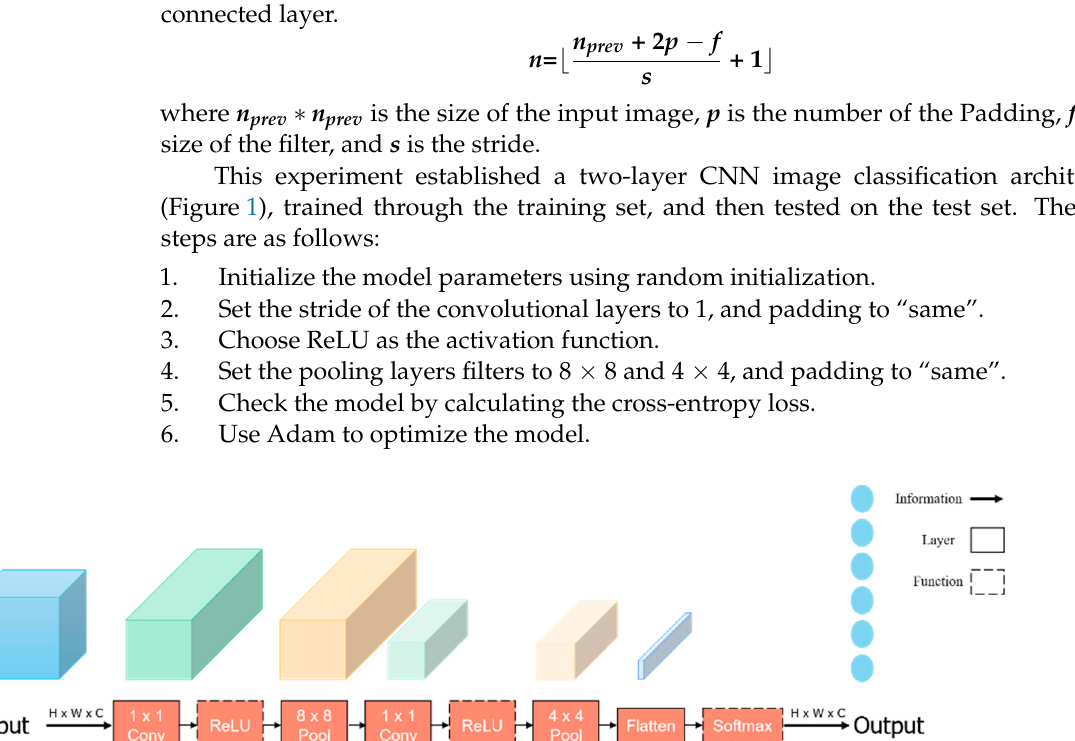
Figure 2. Schematic diagram of the result of the CNN classification model. 3.2. ResNet Model When the network continues to deepen, the deep ordinary network is less capable of selecting the parameters of the learning identity function, resulting in a series of degrada- tion problems, such as gradient disappearance and gradient explosion. Therefore, ad- dressing degradation problems by introducing a ResNet model is an efficient method, which can form a deep neural network by stacking residual blocks. As shown in Figure 3, each two layers added a shortcut connection to form a residual block, with multiple residual blocks forming one residual network. The core of ResNet is the residual block, which is defined as 𝒙 𝒍(cid:2878)𝟏 = 𝒇(cid:4670)𝒙 𝒍 + 𝑭(𝒙 𝒍 , 𝑾 𝒍 )(cid:4671) ; where 𝒙 𝒍 and 𝒙 𝒍(cid:2878)𝟏 are the input and output of the l-th residual unit, respectively; 𝒇 is the activation function; 𝑭 is the residual function; and 𝑾 is the convolution kernel. The residual network [16] uses the original input information to transmit directly to the following layers and avoid accu- racy rising and then plateauing as a result of an excessive number of convolutional layers. Assuming that the input to a particular neural network is 𝒙 , and the expected output after convolution pooling is 𝑯(𝒙) , then the goal of learning is 𝑯(𝒙) . Moreover, in the ResNet model, the input 𝒙 is directly passed to the output, and the learning goal is 𝑭(𝒙) = 𝑯(𝒙) − 𝒙 , which is the residual. The input is directly connected to the following layer through the bypass branch so that the last layer can directly learn the residual error, thereby forming a shortcut connection. Based on this structure, a specific network layer